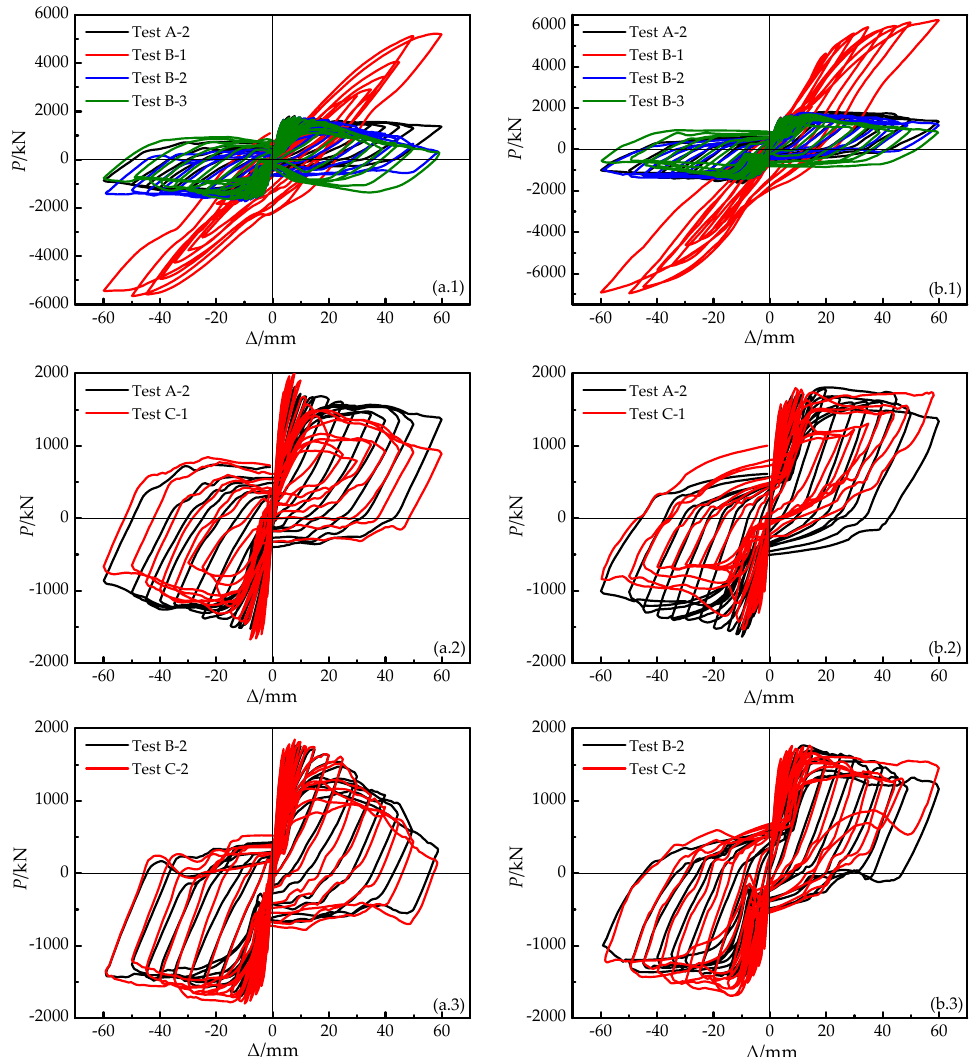
Figure 7. Hysteretic curves of different mesh divisions: ( a.1 – a.3 ) Node8; ( b.1 – b.3 ) Node18.